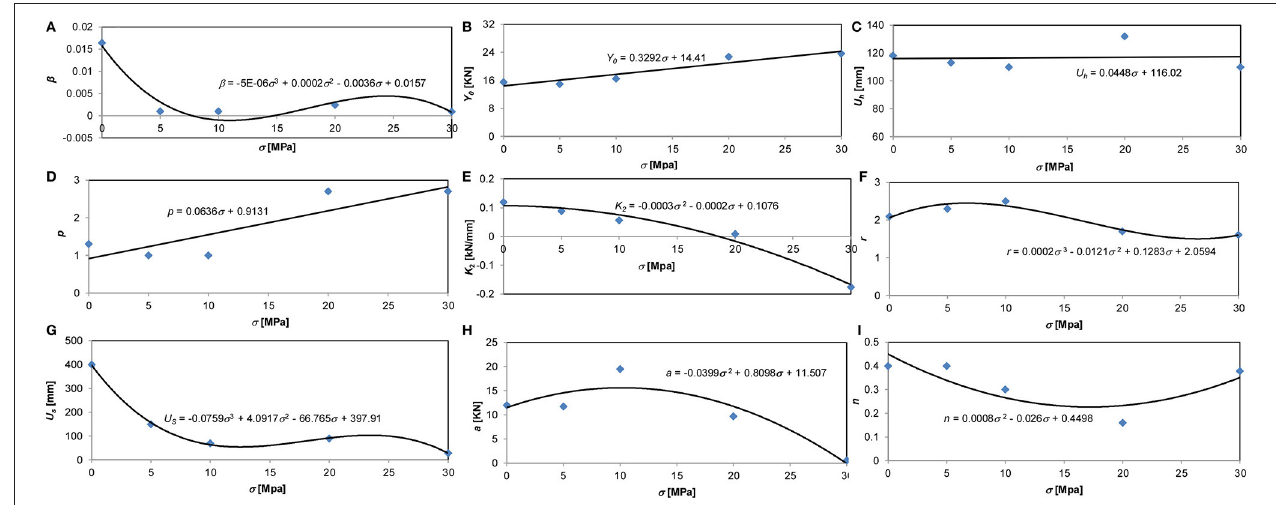
FIGURE 6 | Fitting laws for model parameters in the Superset (A–I)